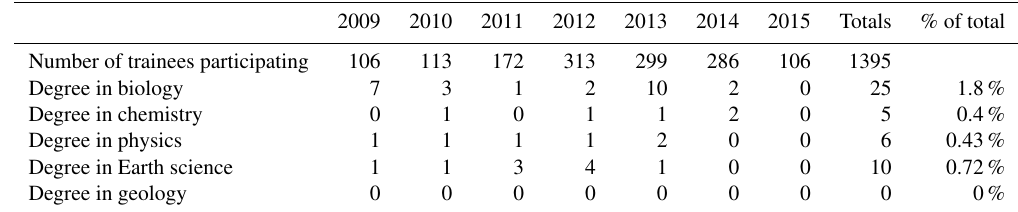
Table 2. Number of trainee teachers with science degrees attending workshops.